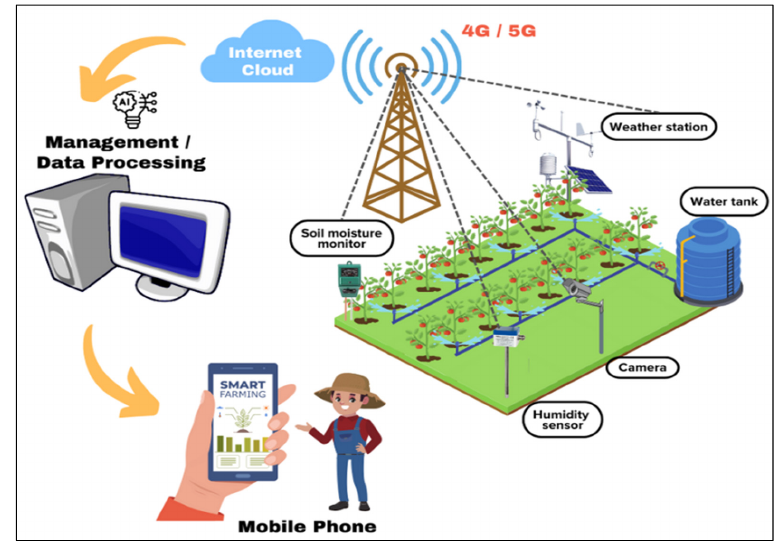
Figure 6. Advanced irrigation hub assisted with real time weather and moisture sensors and decision support systems.